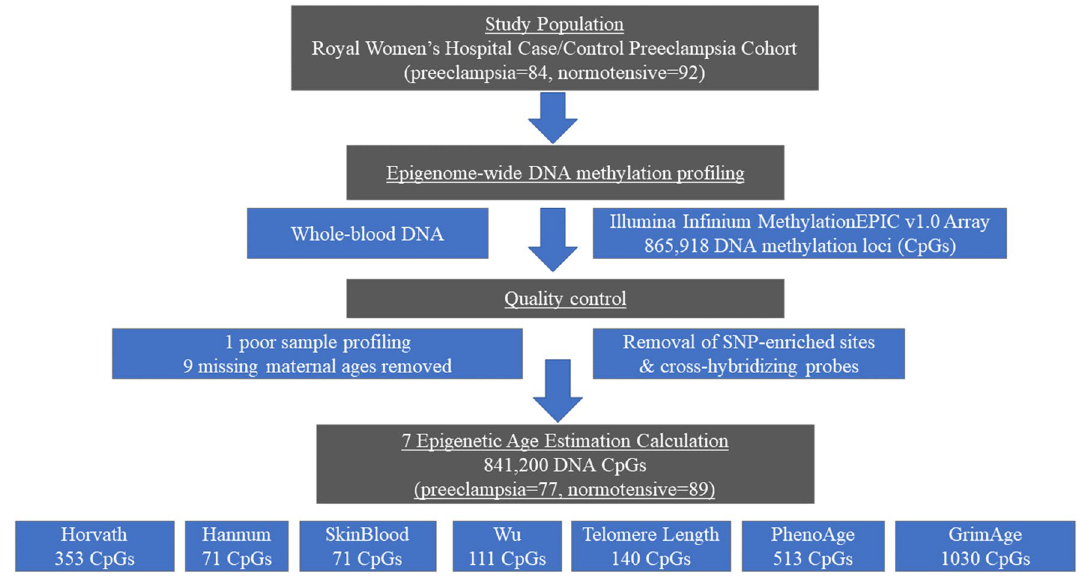
Figure 1. Schematic showing workflow for the